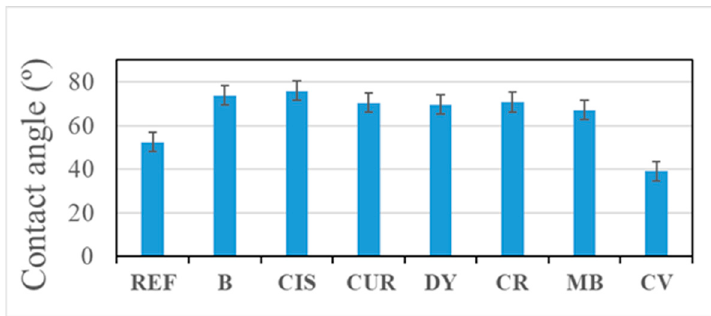
Figure 2. Contact angle values of the samples.